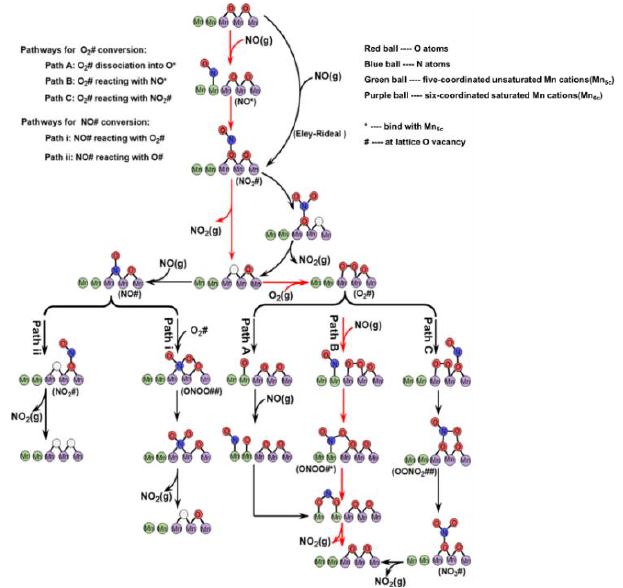
Figure 2. Possible pathways of NO oxidation with the Mars–van Krevelen mechanism occurring on Mn 5c site and lattice O on MnO 2 . The red pathway represented the favoured mechanism of NO oxidation on MnO 2 . Modified from [26] with permission from the American Chemical